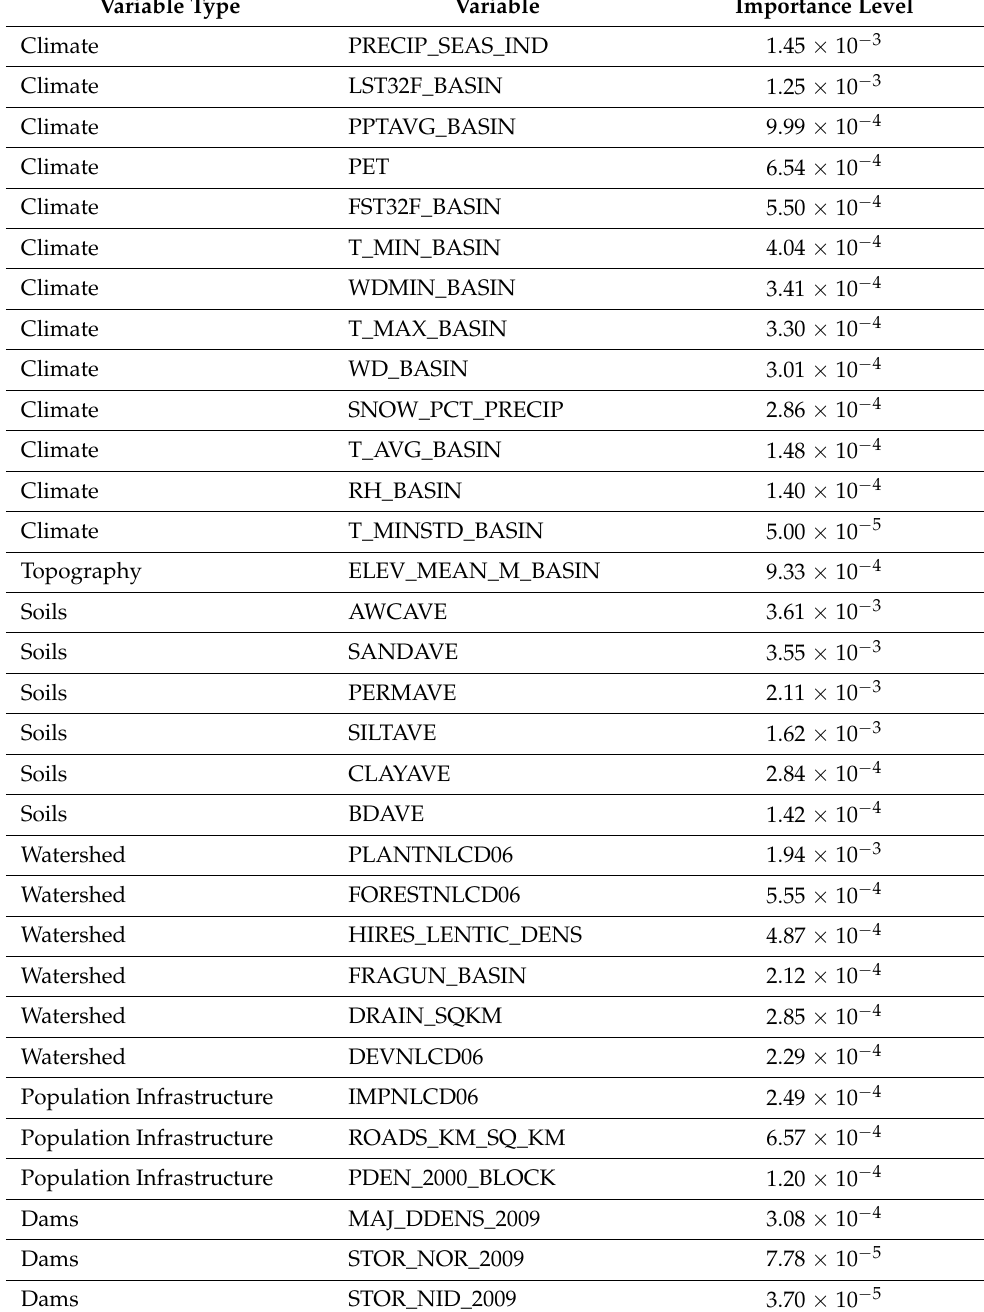
Table A3. Predictor variables retrieved for Coastal